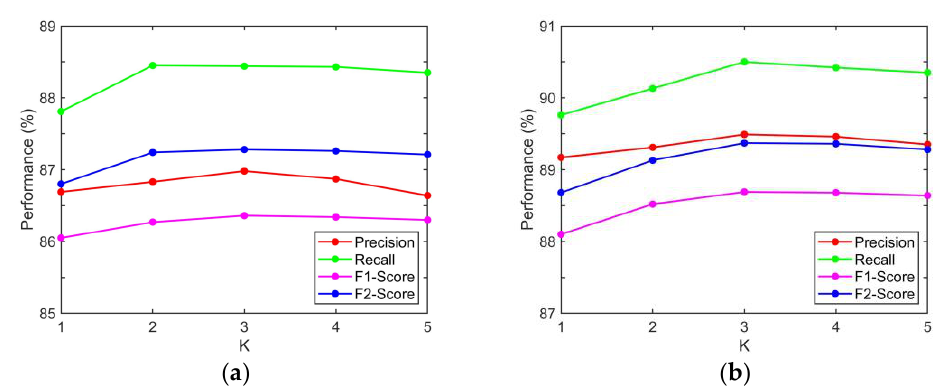
Figure 7. Performance comparisons with different values of K: ( a ) Performances on the UCM multi-label dataset; ( b ) Performances on the AID multi-label dataset.